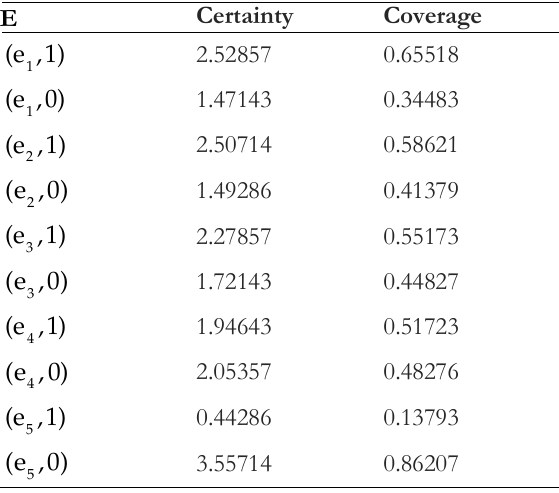
Table 4. Certainty and coverage of parties .